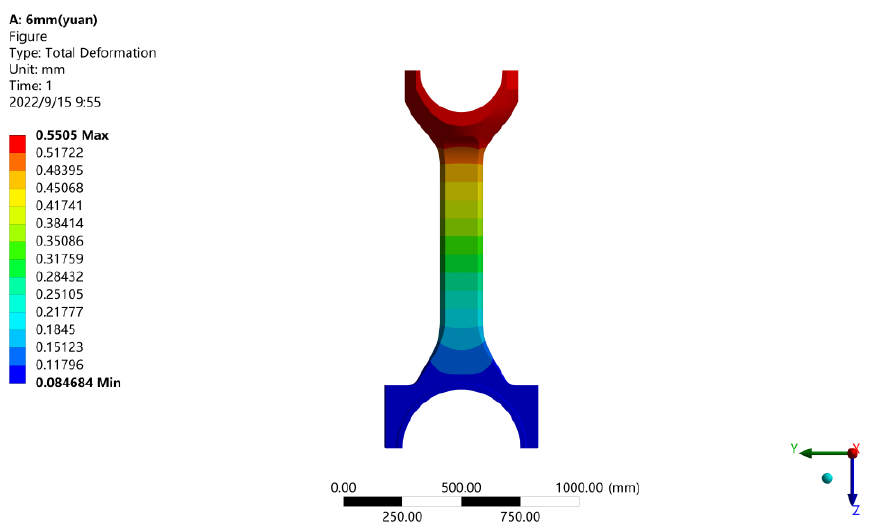
Figure 15. Deformation diagram of connecting rod body.